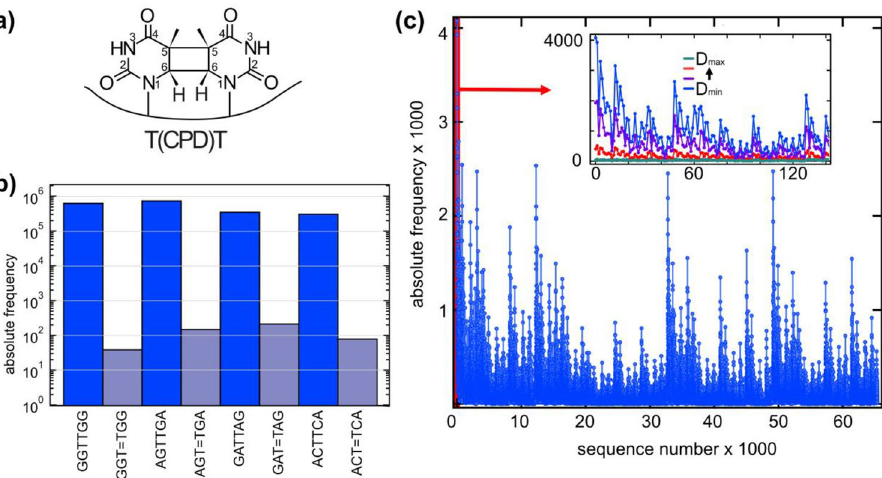
Figure 2. Cyclobutane Thymine Dimer (T=T) lesion and its detection by next generation sequencing. ( a ) Molecular scheme of the T=T-lesion with the cyclobutane ring formed with atoms C5 and C6 of the adjacent thymines. ( b ) Comparison of different hexamers containing an intact central TT sequence in comparison to the corresponding hexamers containing a T=T lesion at the same position. The test experiment clearly shows that the hexamers containing a T=T lesion show much smaller (more than 1000-fold) absolute frequencies than the intact hexamers. The large discrimination demonstrates that the proposed technique (Step 3 and 4) is well suited to detect the T=T damage by allowing only fully intact strands to be successfully sequenced. ( c ) Frequencies of the 65,536 sequences from a pool of DNA strands with eight central randomers (raw data). The synthesis of the sample, the preparation of the library and the sequencing result in sequence dependencies for the unexposed sample, which must be considered in the further analysis. Insert: Frequencies for a selection of sequences taken with increasing exposure (blue: unexposed, to green: maximum dose) showing sequence dependent decrease of the